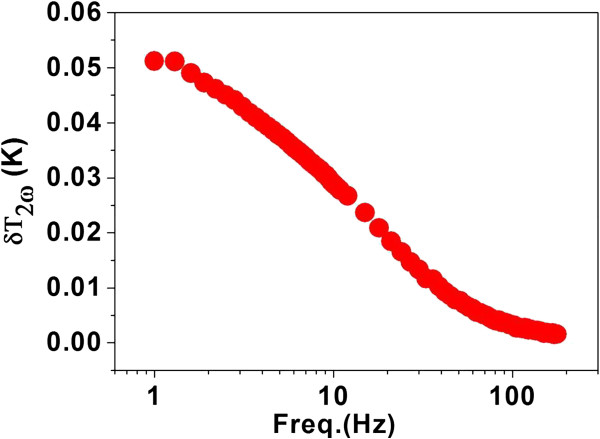
Typical temperature oscillation δT2ωas a function of frequency measured in PVP-stabilized ZnO nanofluid.